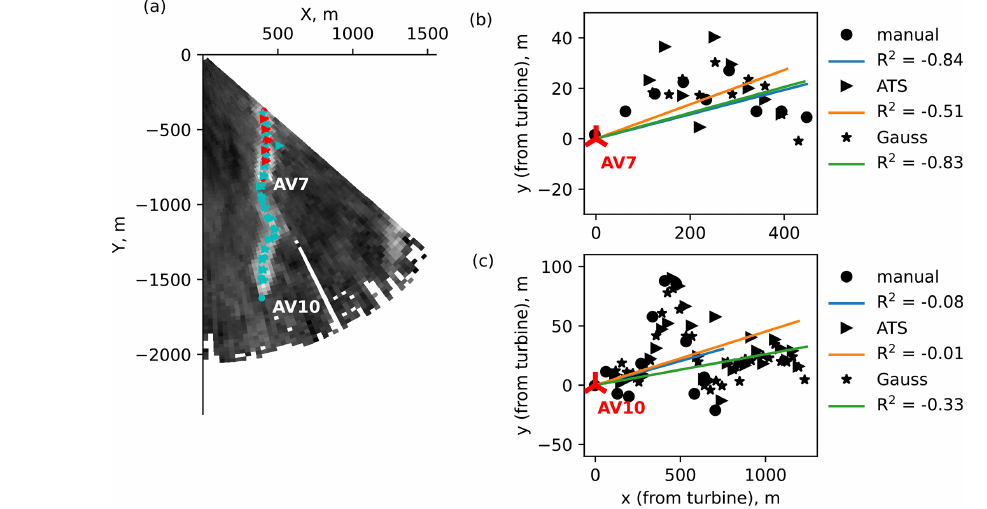
Figure 19. Scan 221 (aligned-wake subset). (a) An overview of the detected centerlines and regression fits for (b) AV7 and (c)